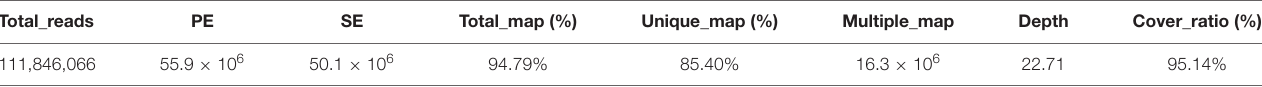
TABLE 1 | Summary of original re-sequencing data of Munake cultivar.